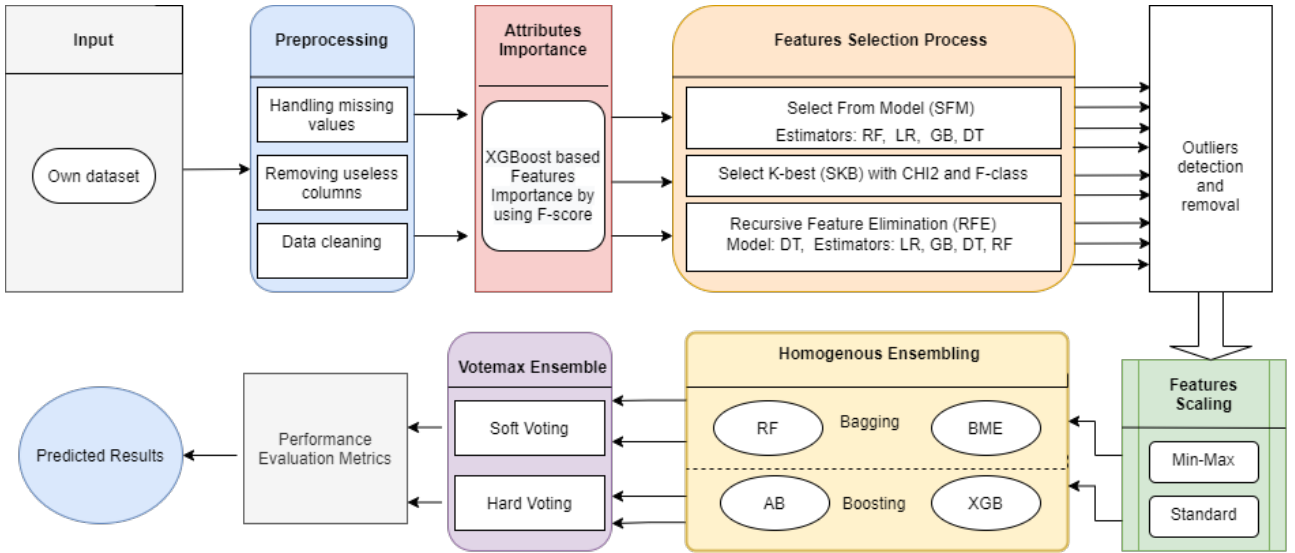
Figure 1. General block diagram of the proposed methodology for the diagnosis of thyroid